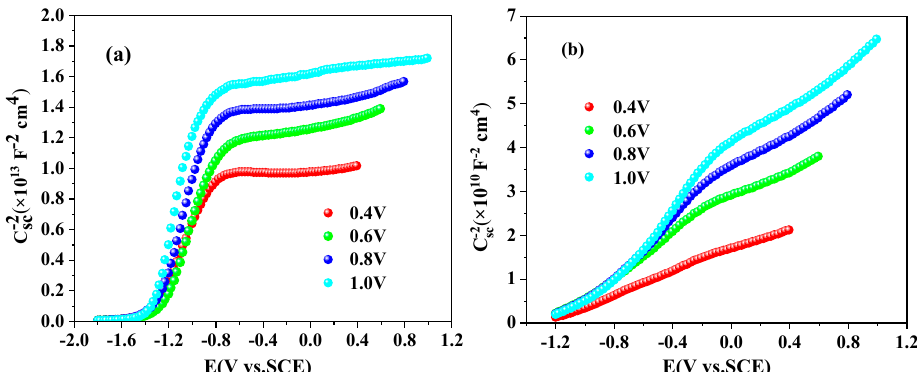
Figure 10. Mott–Schottky plots of the passive films developed on ( a ) the niobium coating and ( b ) the Ti–6Al–4V substrate at different potentials (0.4, 0.6, 0.8, and 1.0 V) in Ringer’s solution at 37 °C.